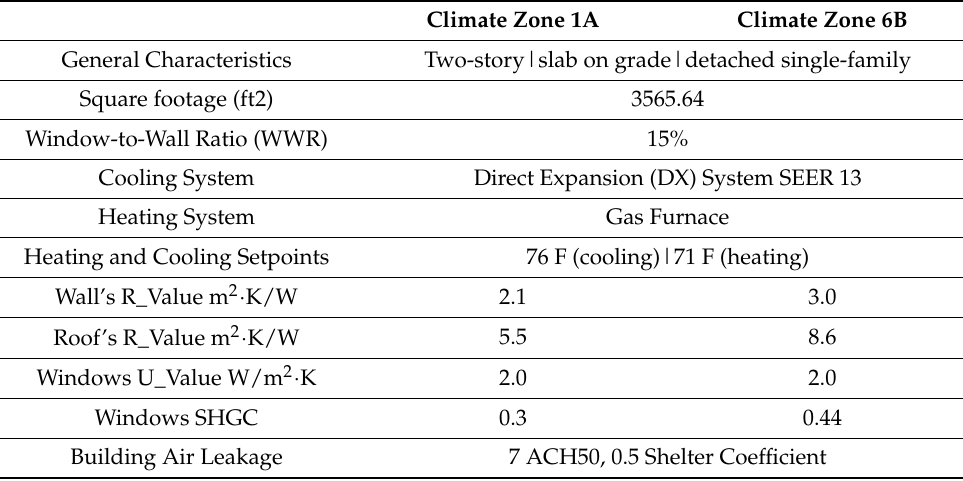
Table 7. Baseline building characteristics for two climate zones based on IECC 2006.